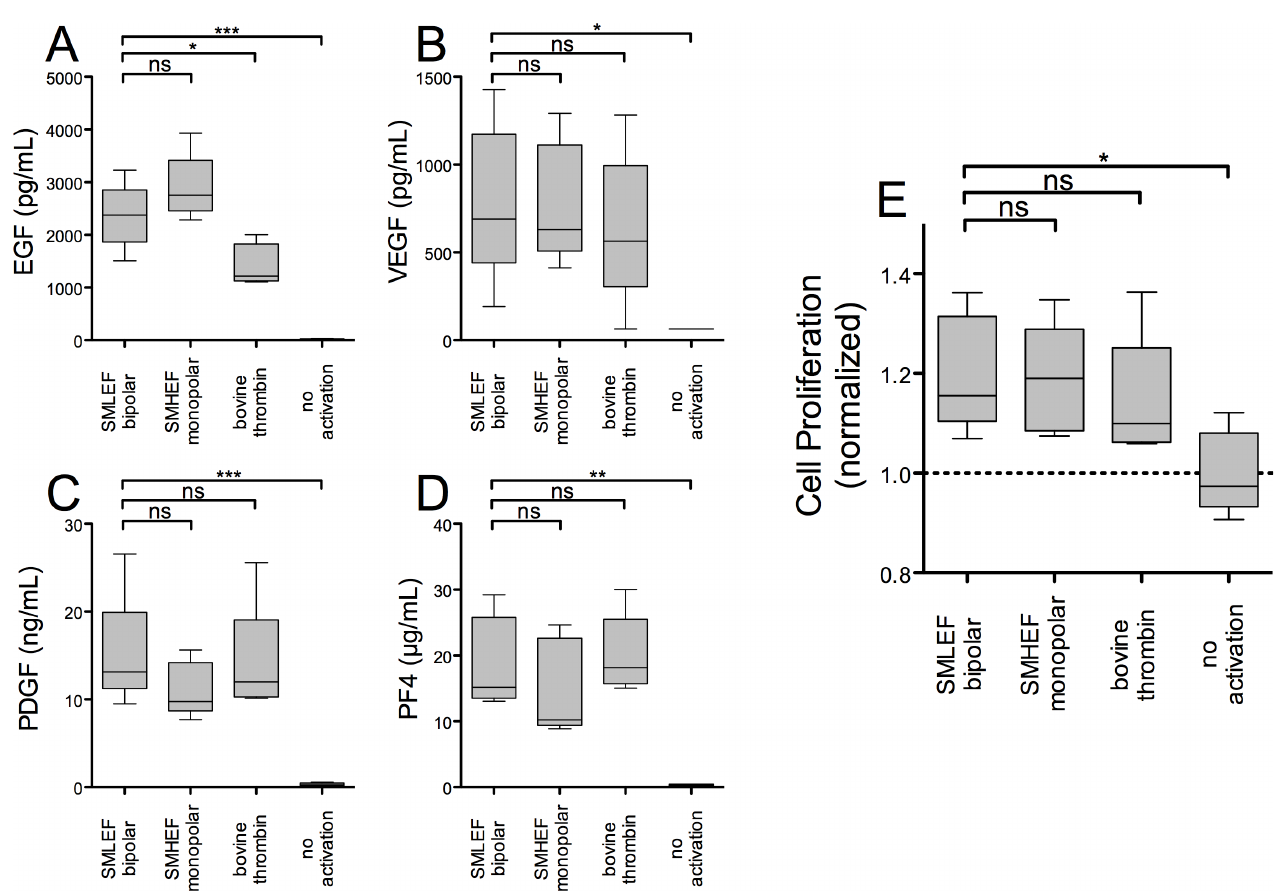
Fig 3. Growth factor release and stimulation of cell proliferation. PRP, treated as described in the Methods, was centrifuged, the supernatant recovered and assayed for pro- and anti-angiogenic factors by ELISA and for stimulation of cell proliferation using serum-starved epithelial cells (MCF10A). Cell proliferation in response to the plasma supernatants of unactivated or activated PRP (panel E) is normalized to that obtained with supernatants of unactivated PRP. Purified recombinant human EGF 100 ng/mL added to serum-free media increased cell proliferation 1.75-fold relative to media alone (data not shown). Results shown are means ± SEM, n = 5. * p < 0.05, ** p < 0.01, *** p <